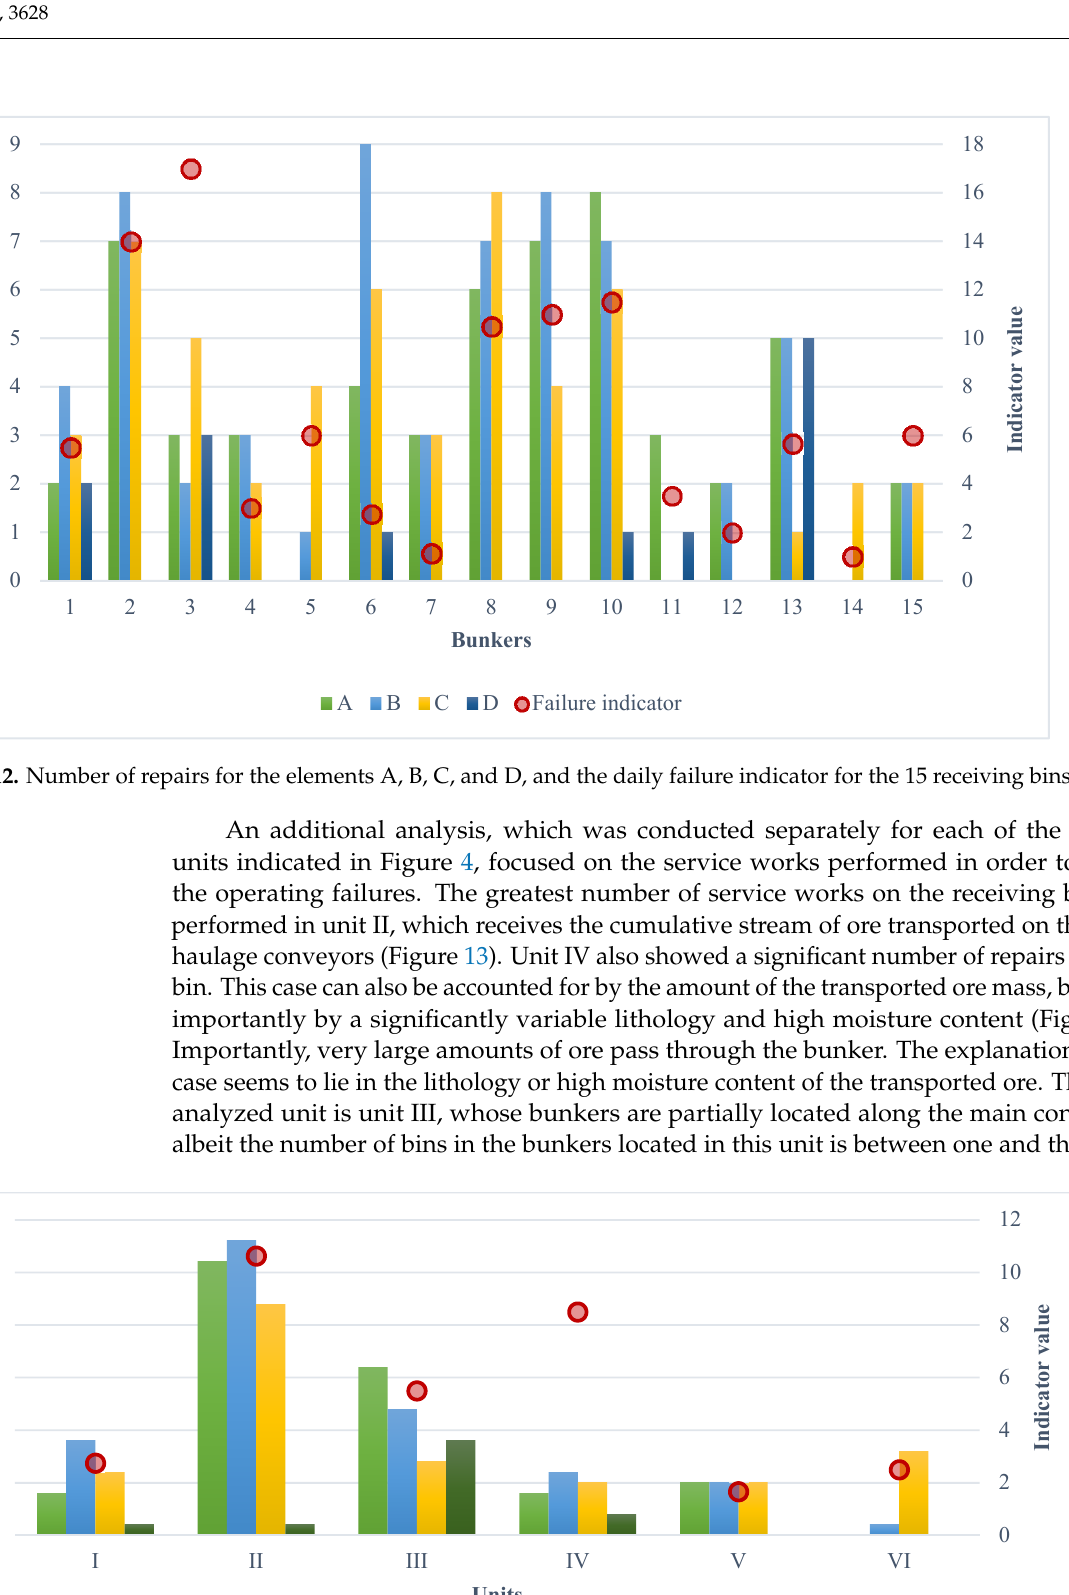
( c ) Figure 14. Different types of the transported ore : (a) large rock lumps, ( b ) dry ore, ( c ) moist ore. The analysis demonstrates that the mass of the ore passing through a bunker has a significant influence on its failure rate, and therefore a mass indicator was proposed in further research in order to describe what mass of ore determines the occurrence of a par- ticular failure type in the elements A–D. For this purpose, total masses of ore passing through individual bunkers over the analyzed time period and number of repairs per bunker were calculated. The results of the measurements performed as part of this re- search are shown in Table 4 and in Figure 15. The greatest amounts of ore passed through bunker 9 (unit II), 6 (unit I), 7 (unit V), and 8 (unit II). Taking into account repairs for the elements A, B, C, and D, the indicators were calculated respectively for each of the bunkers. The results provided in the graph do not include the indicator for the element D, as its failures were occasional. The mass indicators demonstrate that in bunkers 2, 7, 8, 10, and 15 the elements A, B, and C undergo wear at a comparable speed, but with intensity different for each bunker. Failures of the vertical sealings B dominate in bunkers 3 and 5, while in bunkers 9, 13, and 14 the majority of failures (critical wear) occur in the case of linings on the side walls of the hopper C. The most frequent repairs were performed for bunker 10—every 0.8 million Mg, on average. In the case of bunkers 2, 7, 8, and 15 the repair frequency is every 1.3 million Mg, 3.6 million Mg, 1.5 million Mg, and 1.2 million Mg, respectively. In bunkers 3 and 5, the vertical sealings are replaced rarely in comparison to other repairs (on average every 4.7 million Mg and 6.3 million Mg). A different scope of repairs is observed in the